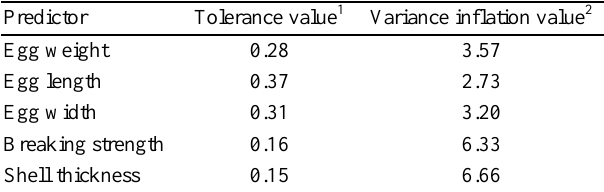
Table 3. Diagnoses of multicollinearity among the predictors Predictor Tolerance value